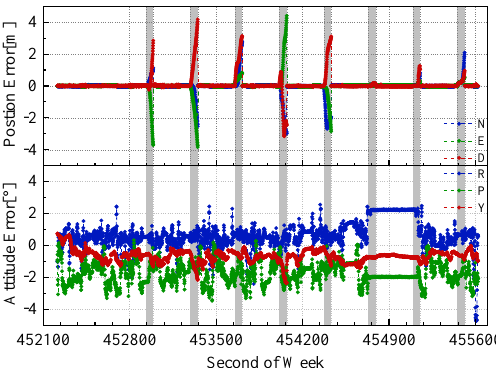
Figure 10. Position and attitude errors of the GNSS / INS integrated navigation system in the GNSS outage simulation test #2.